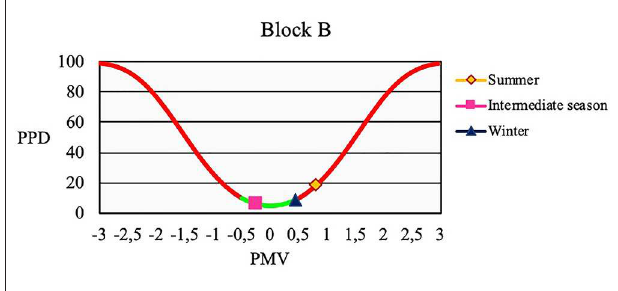
FIGURE 7 | PMV and PPD indices for Block